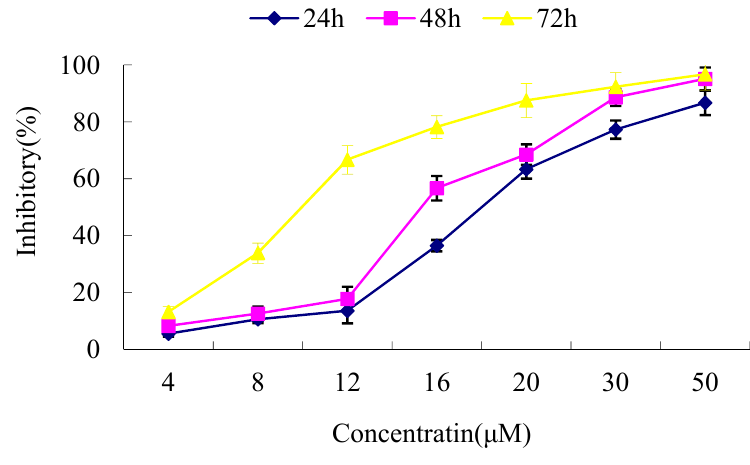
Figure 4. Effect of tamoxifen towards keloid fibroblast as determined by MTT